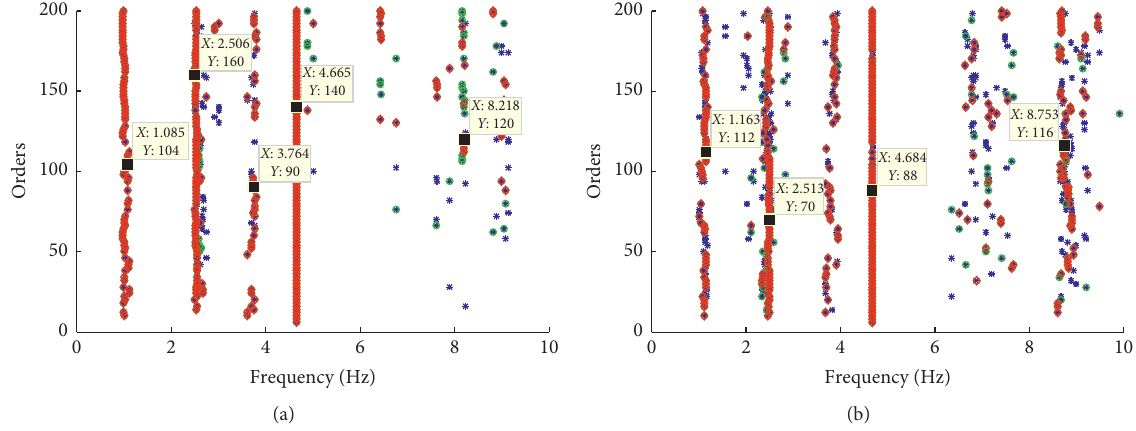
Figure 10: Stability diagram (working condition: C1). (a) Stability diagram (time: 0s–4 s). (b) Stability diagram (time: 2s–6 s).